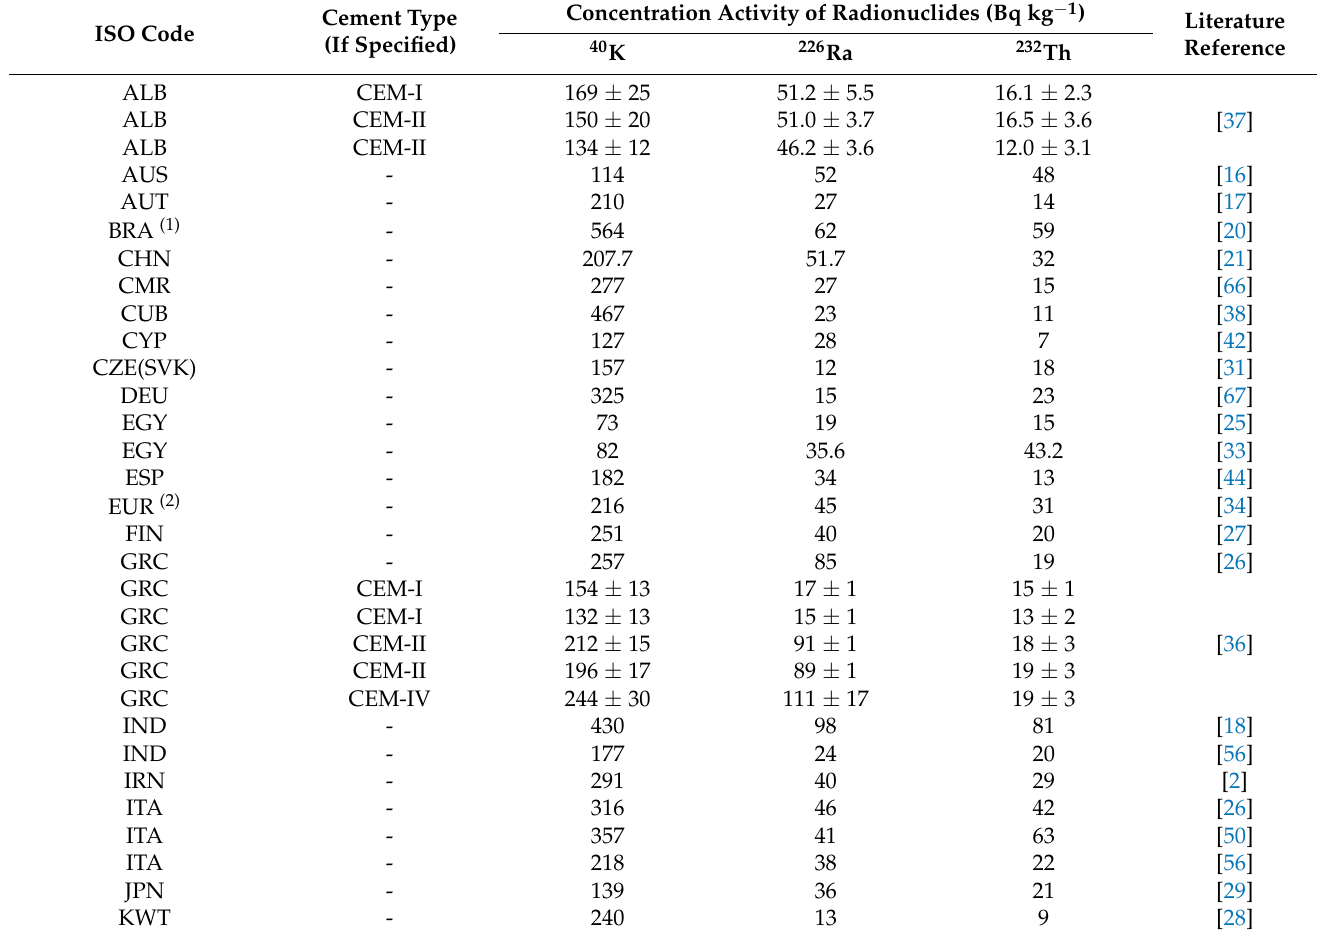
Table 4. Data received from other studies presenting measurements of radionuclides activity con- centrations of 226 Ra, 232 Th, and 40 K. Where it was possible, also information on the cement type was retrieved.